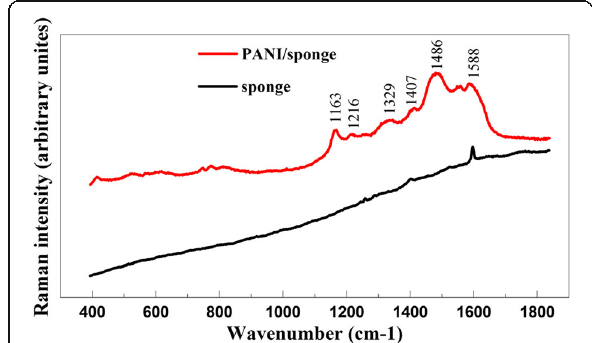
Fig. 4 Raman spectrum of pristine sponge and sponge after in